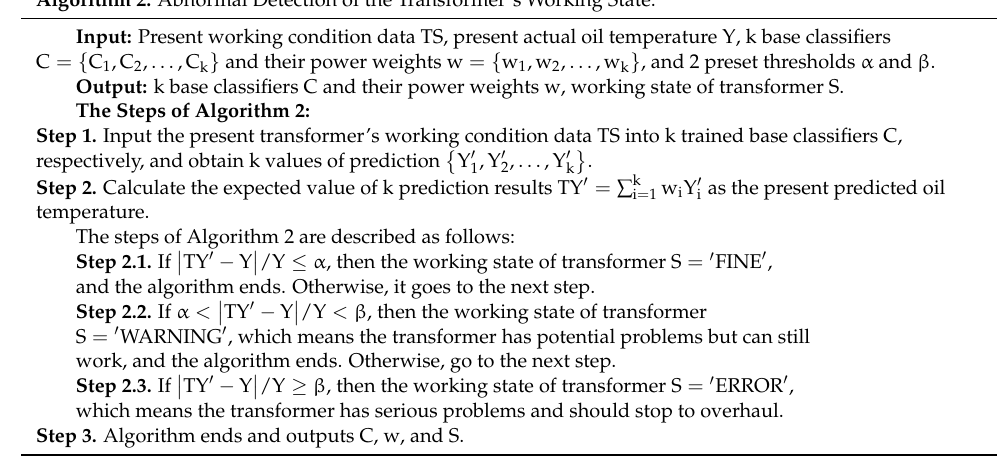
Algorithm 2. Abnormal Detection of the Transformer’s Working